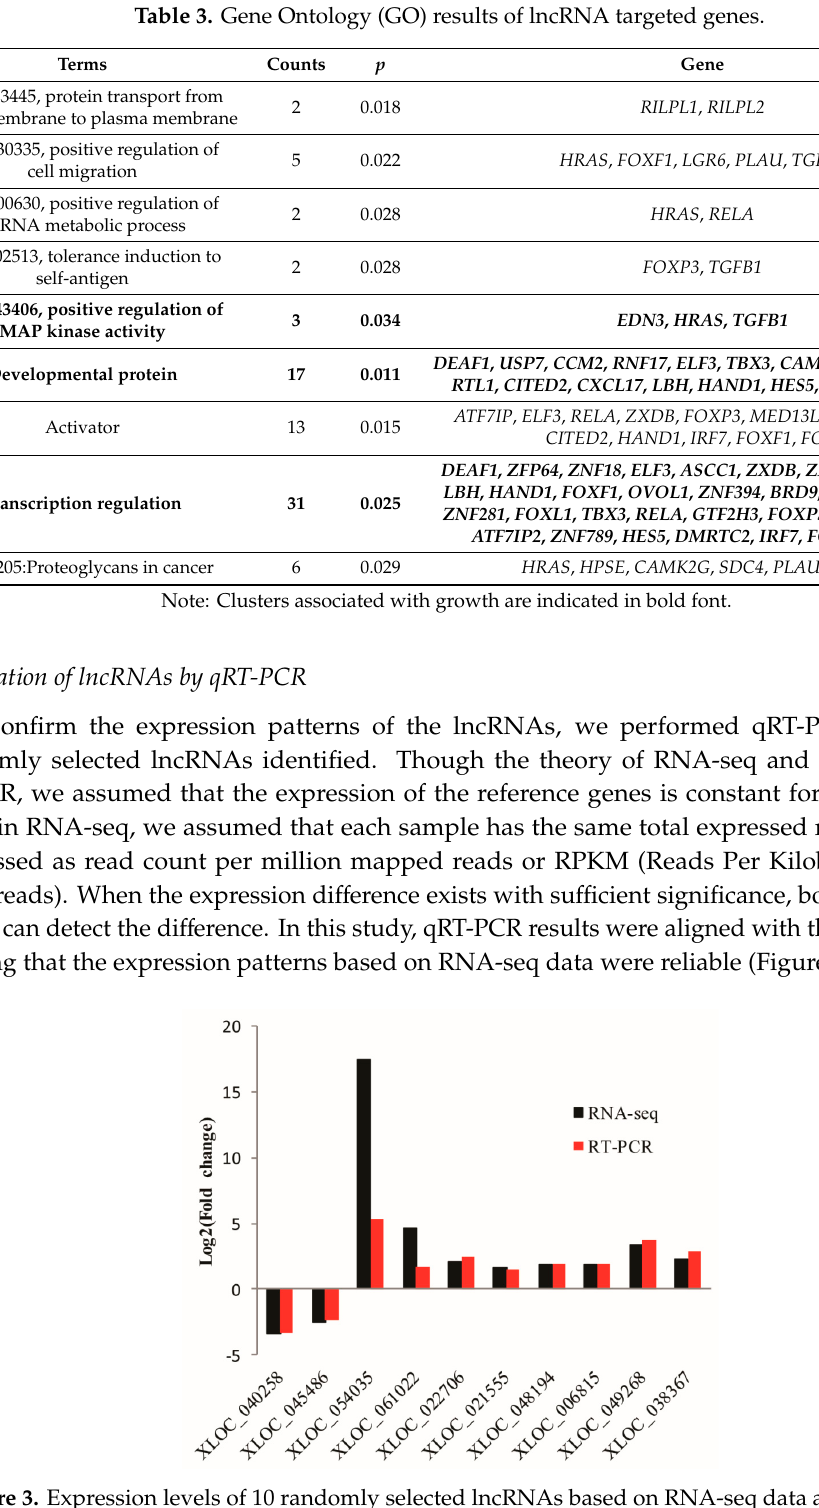
Figure 3. Expression levels of 10 randomly selected lncRNAs based on RNA-seq data and qRT-PCR validation. log2Fold change (FC) > 0 or < 0 indicate the upregulated or down-regulated transcripts in Yili horses compared to Ningqiang ponies, respectively.